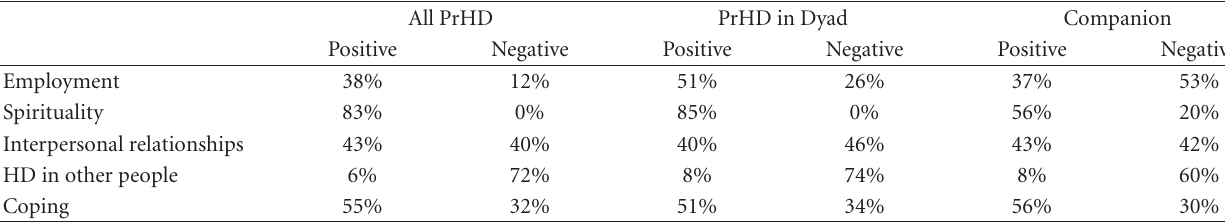
Table 2: Valence of QOL statements by content domain.